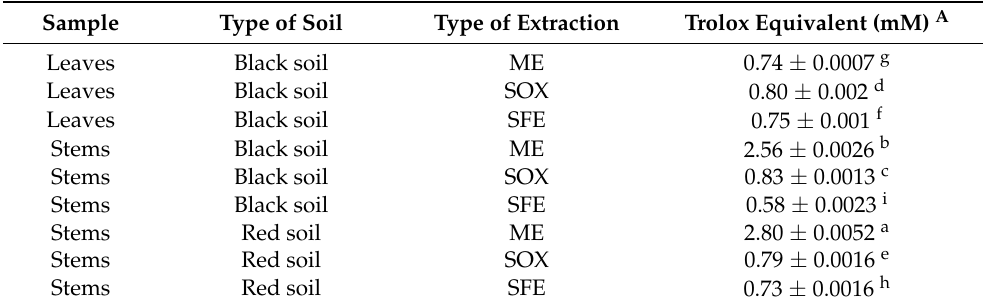
Table 4. Antioxidant activity of extracts of leaves of plants grown in black soil and stems of C. chinense of plants grown on black and red soil obtained by ME, SOX and